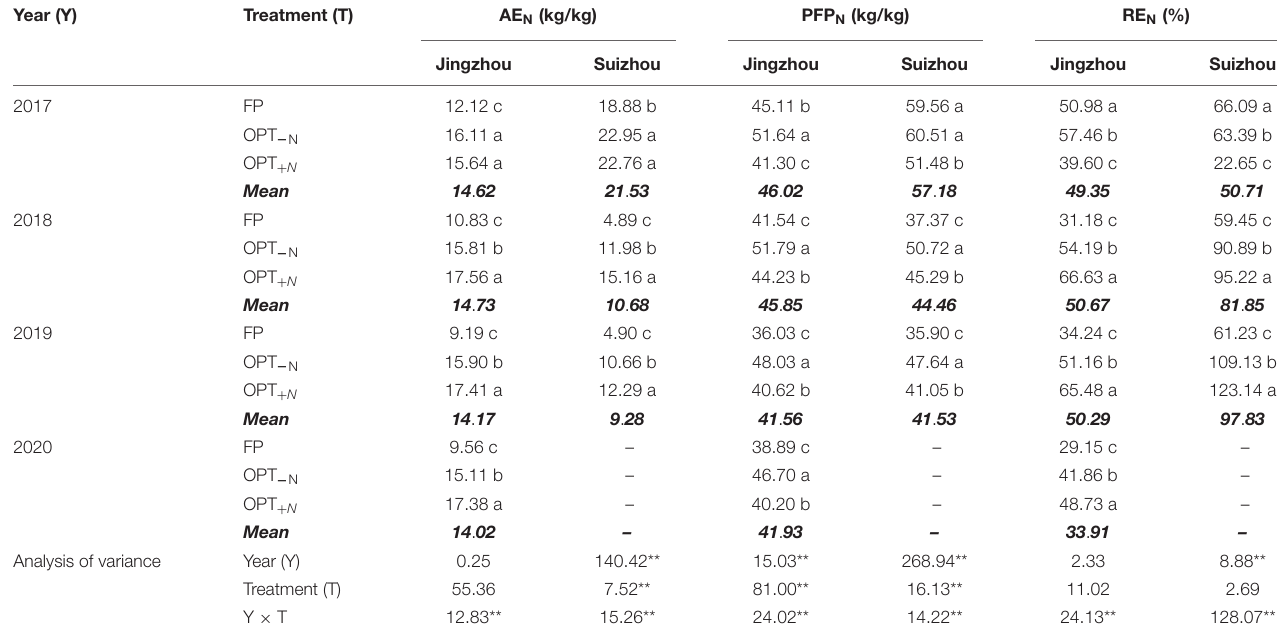
TABLE 6 | Agronomic efficiency of applied N (AE N ), partial factor productivity of applied N (PFP N ), and crop recovery efficiency of applied N (RE N ) in Jingzhou and Suizhou. Year (Y) Treatment